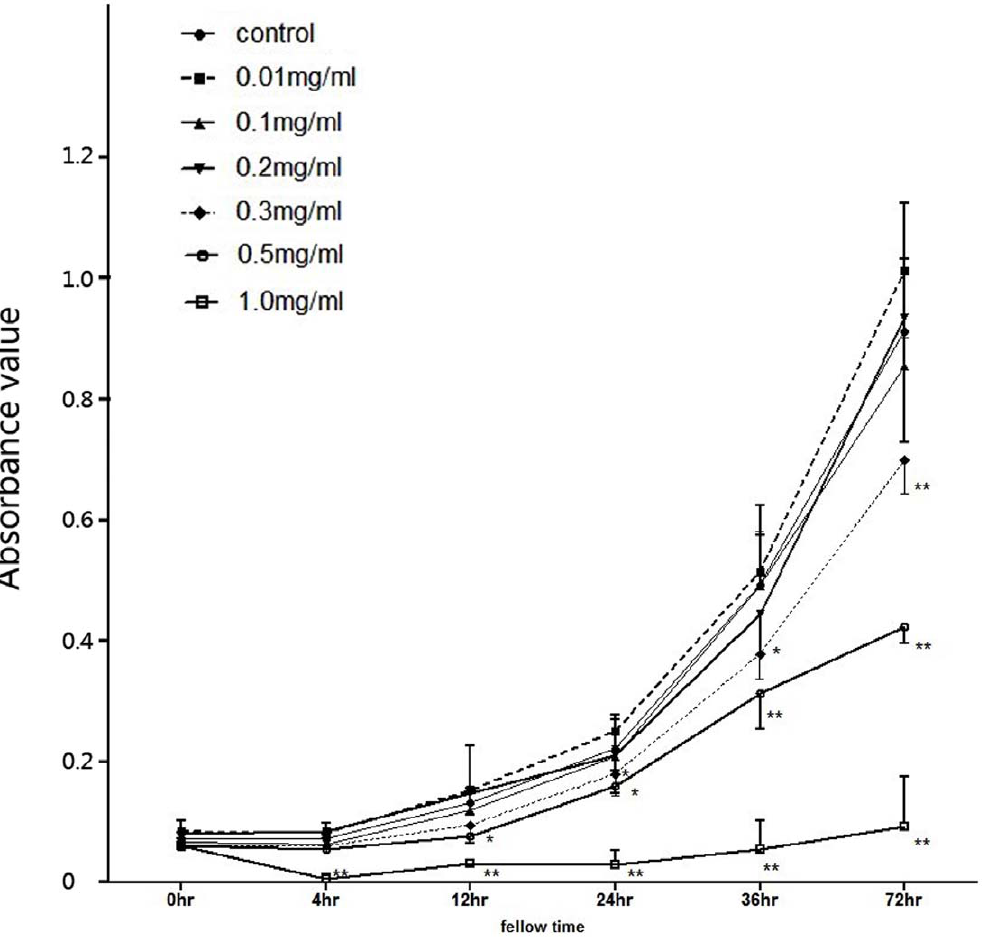
Figure 1. Inhibitory effect of pirfenidone on proliferation of SRA01/04 cells as measured by MTT assay. Cells with 10% FBS were treated with 0, 0.01, 0.1, 0.2, 0.3, 0.5, or 1.0 mg/mL pirfenidone for 0, 4, 12, 24, 48, or 72 hours. Data are derived from the mean 6 SD of triplicate results in three independent experiments. *P , 0.05, and **P , 0.001 from comparisons between cells with treatment and control cells with 10% FBS, at different time